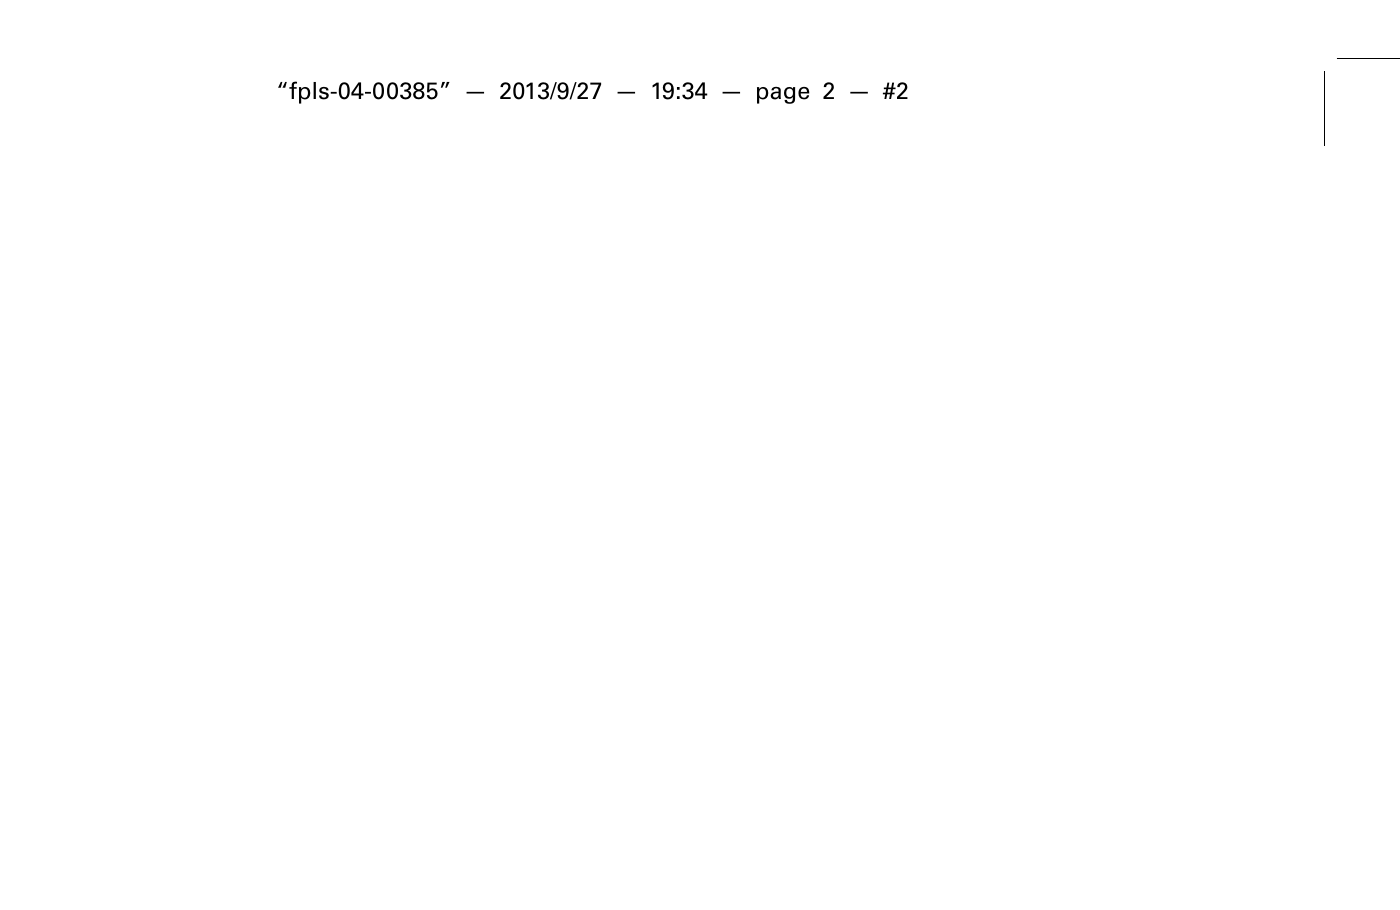
FIGURE 1 | Regulation of nodule and lateral root formation in low and high N. Low N promotes the formation of lateral roots and nodules. Lateral root formation increases in low N to promote foraging. However, if the root senses a patch of high N during N-limitation, lateral root elongation is promoted towards the high N-patch to exploit the available N-source for the plant use. In low N, legume roots are susceptible to rhizobial infection and form nodules in which N is fixed by rhizobia and transported into the plant.The